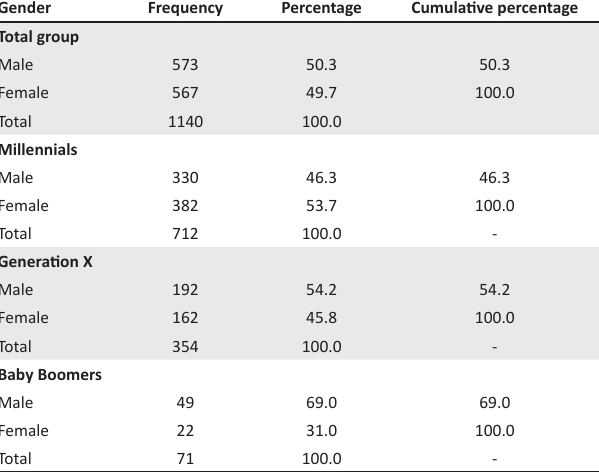
TABLE 4: Respondents’